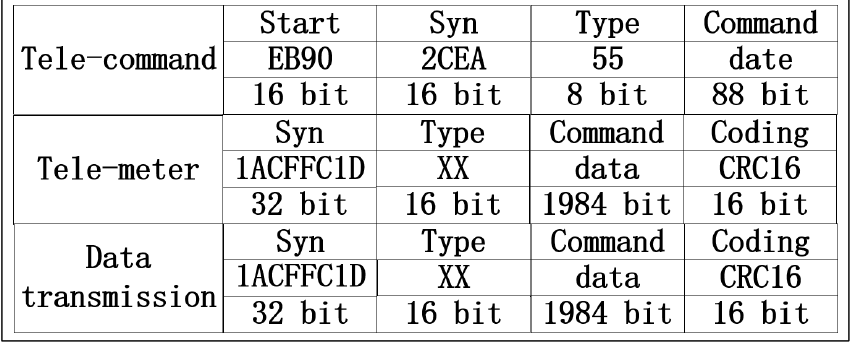
Figure 2. SSS-2A data packets.